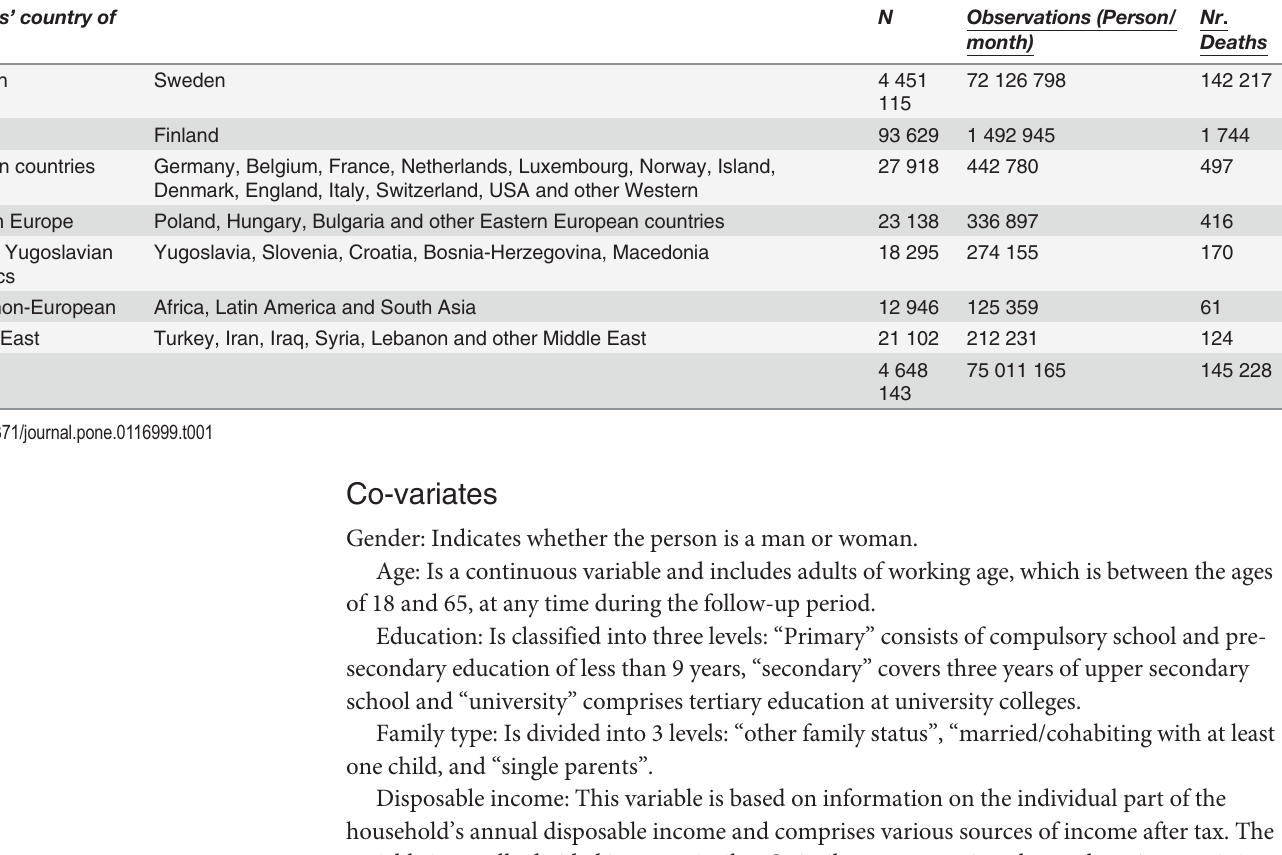
Table 1. Parents ’ country/region of birth, person-time and number of deaths in the study population (1990 – 2008). Parents ’ country of birth